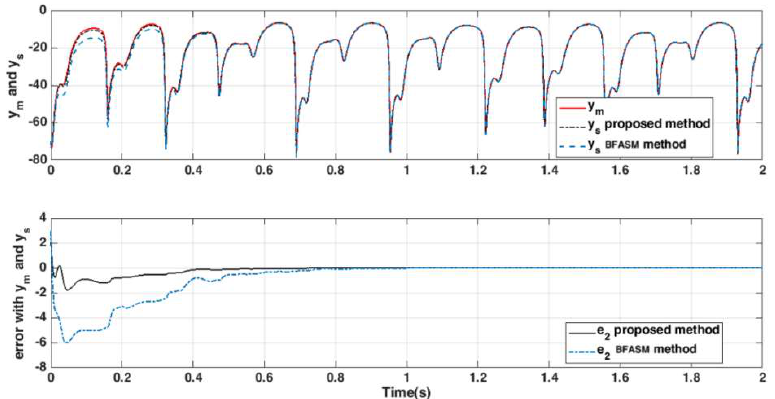
Figure 9. Chaos synchronization and synchronization error of master–slave systems in y m , y s .